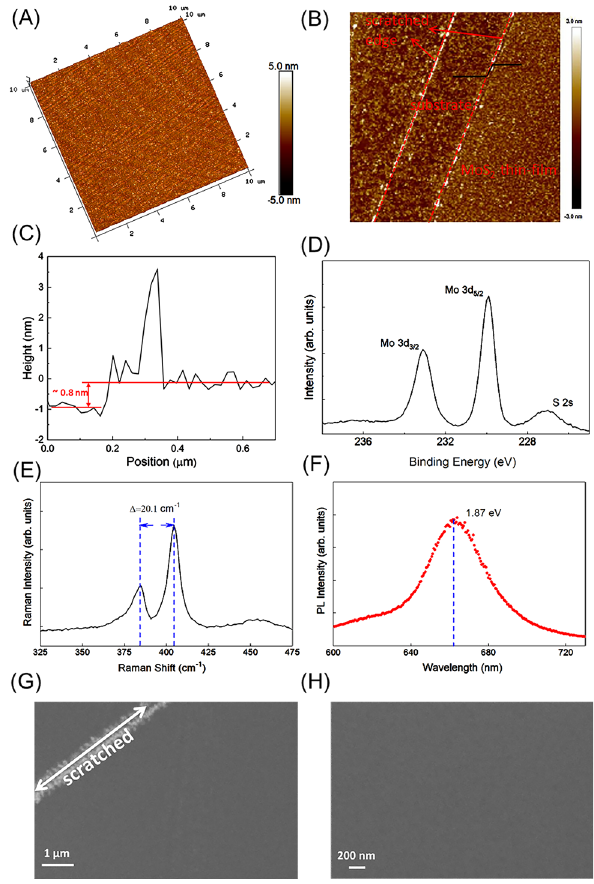
Figure 1: Characterizations of the deposited monolayer molybdenum disulfide (MoS 2 ) on the sapphire substrate. (A) Atomic force microscopy (AFM) image, (B) AFM height image of the as-grown MoS 2 thin fi lm, (C) line scan across the MoS 2 thin fi